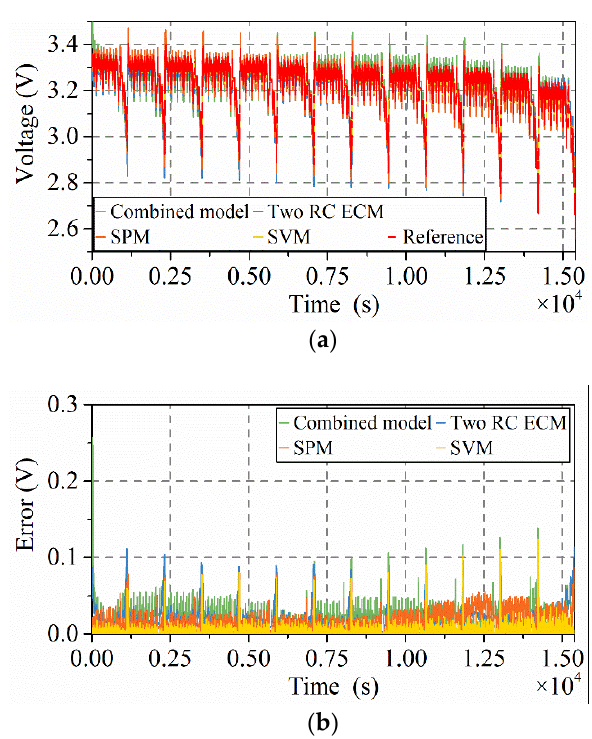
Figure 8. Voltage prediction achieved by using the four models. ( a ) Voltage; ( b ) absolute error.